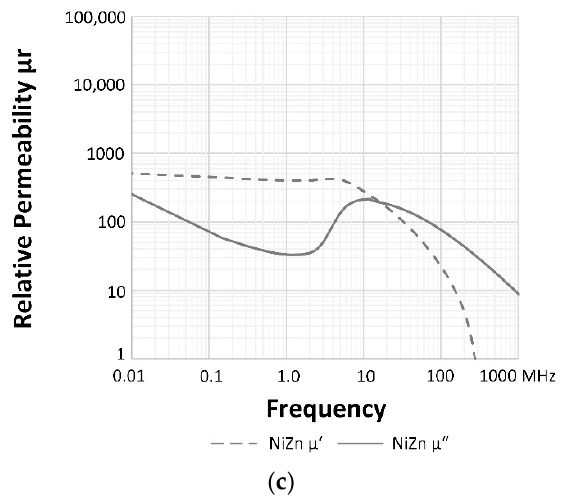
Figure 3. Complex relative permeability split into real and imaginary components: ( a ) NC sleeve ferrite core; ( b ) MnZn sleeve ferrite core; ( c ) NiZn sleeve ferrite core.